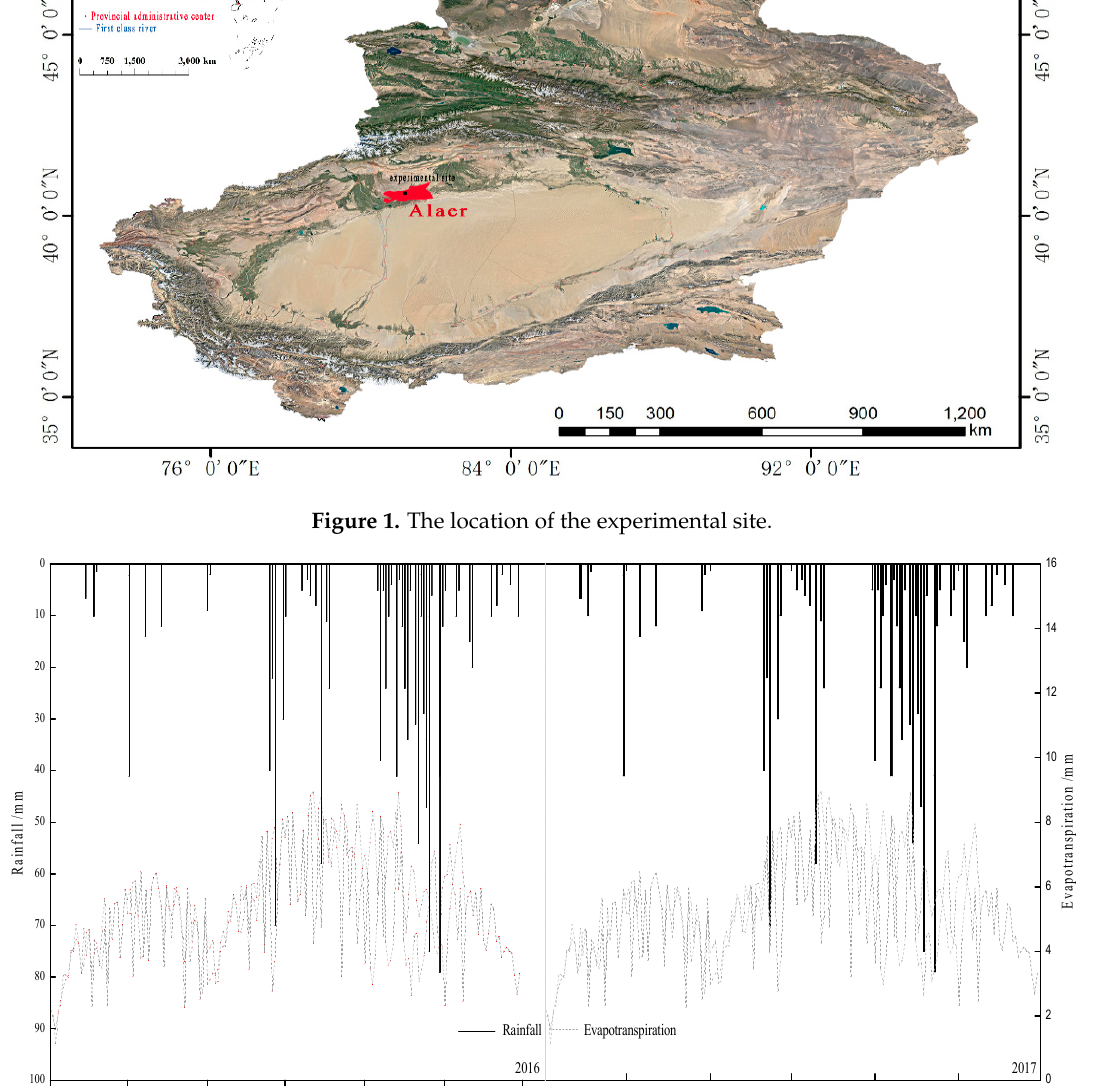
Figure 2. Reference evapotranspiration and rainfall during the experiment. Table 1. Soil properties used in the experiment.